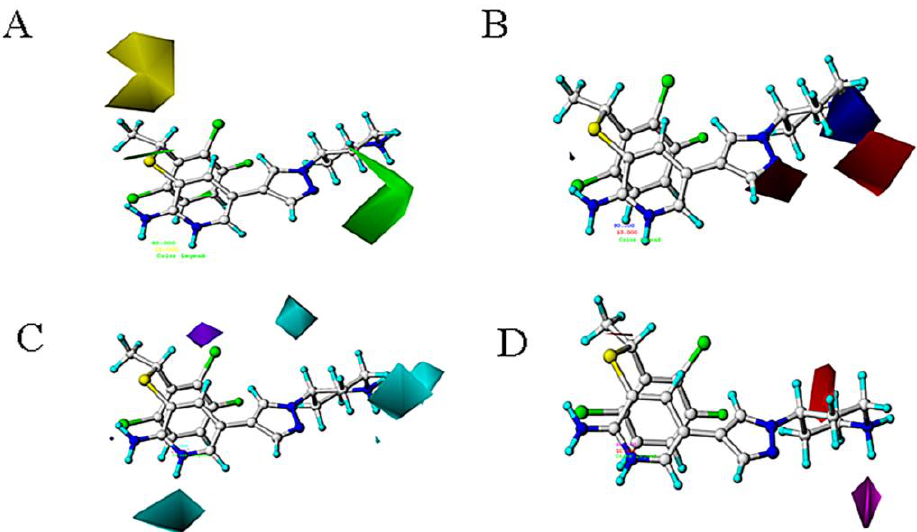
electrostatic field.